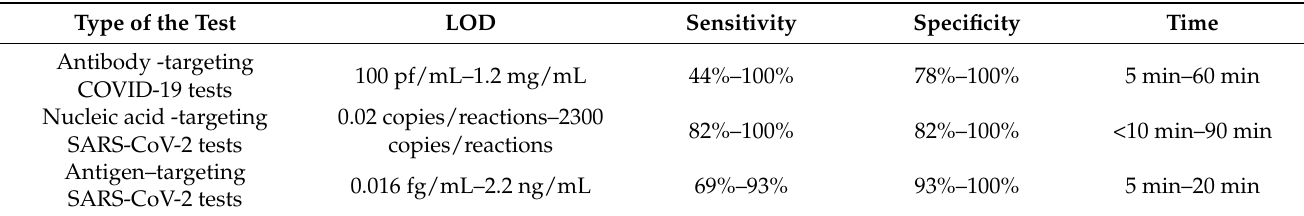
Table 6. Summary of LFA based tests for COVID-19 diagnostics